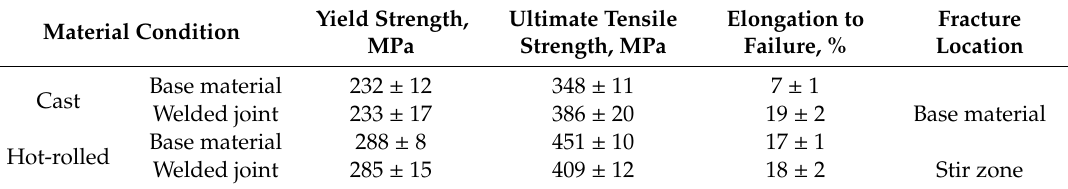
Table 4. Tensile properties of 6061 alloy